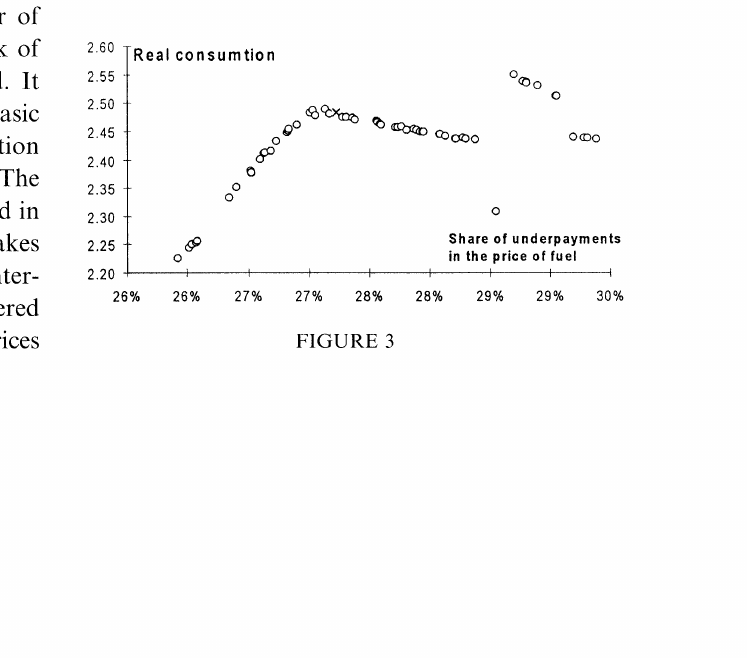
tSverdlovsk region imports almost all